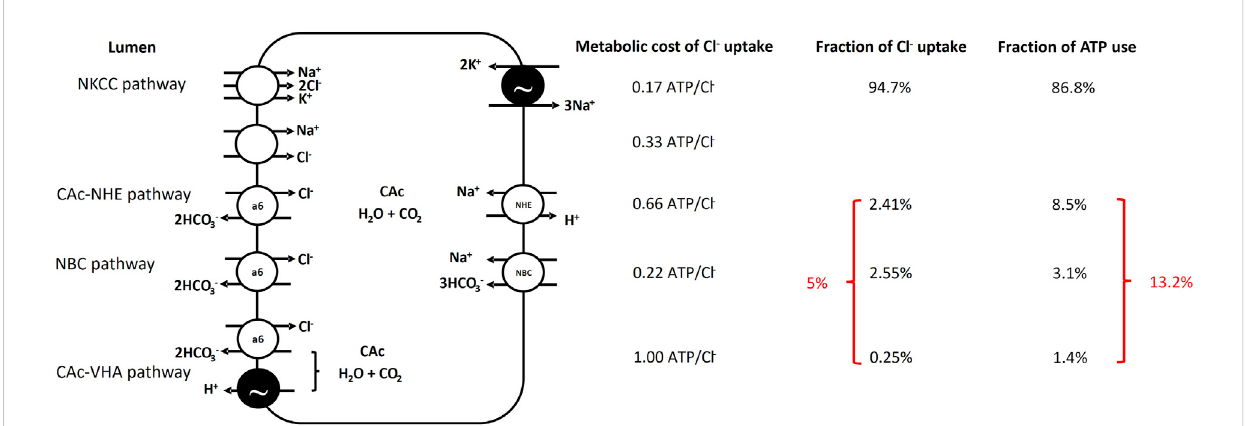
FIGURE 2 Schematic representation of Cl − absorption pathways in the Gulf toad fi sh (and likely most marine teleosts) intestine along the theoretical ATP consumption required for Cl − absorption by each pathway, the fraction of overall Cl − absorption conducted by each pathway and fi nally the resulting fractionofoverallATPconsumptionrelatedtoCl − absorptionbyindividualpathways.TheNKCC2pathwayisresponsibleforthemajorityofCl − absorption but there is no evidence for involvement of the Na + , Cl − — cotransporter. The anion transport pathways are generally more metabolically costly than the NKCC2 pathway and speci fi cally, the pathways involving hydration of endogenous CO 2 via carbonic anhydrase are the most metabolically costly. Note that the modest contribution by anion exchange pathways to Cl − absorption of 5% corresponds to 13.2% of the ATP consumption required for Cl − uptake. See text and Table 1 for further information.